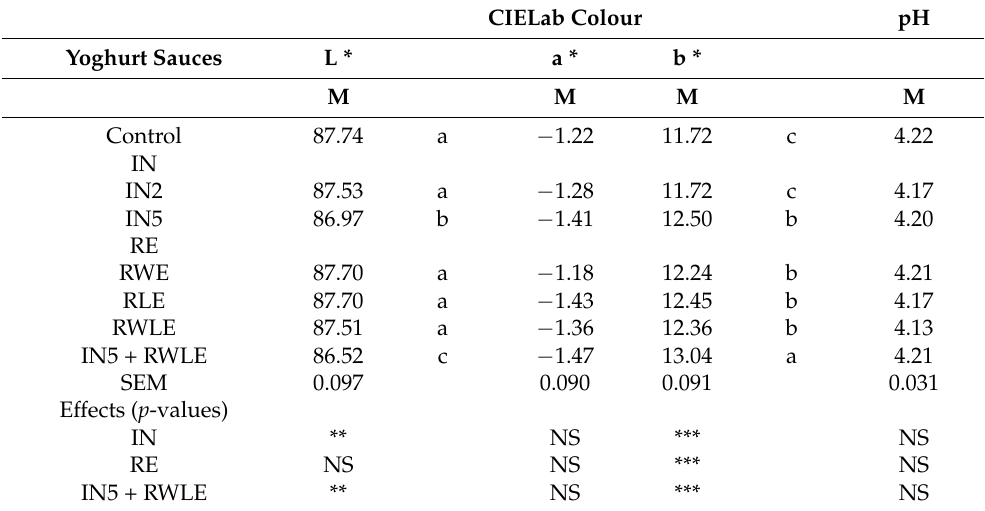
Table 4. CIELab colour and pH values of yoghurt sauces made with inulin and/or rosemary